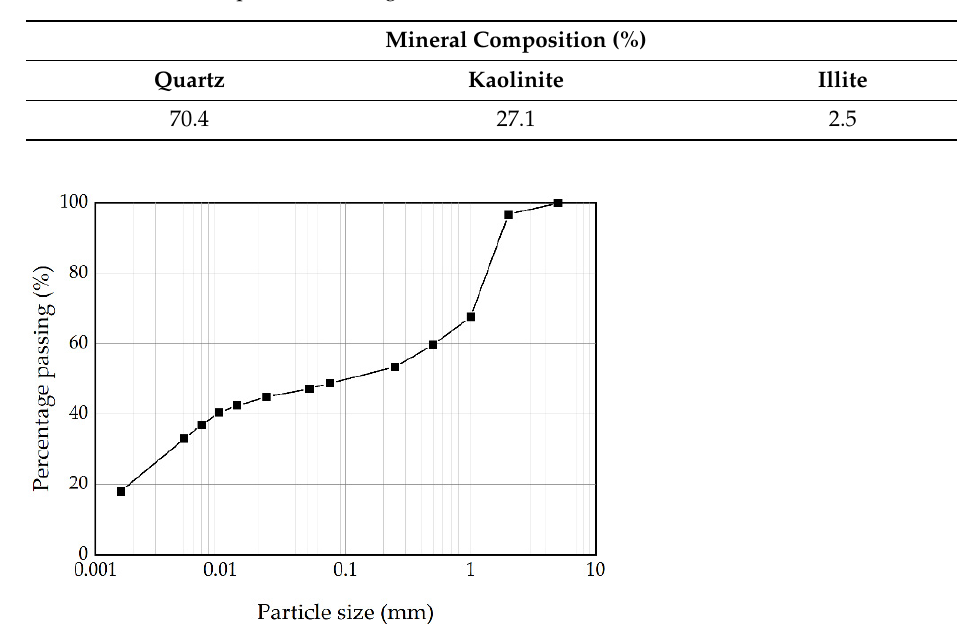
Table 1. Physical parameters of the granite residual soil.